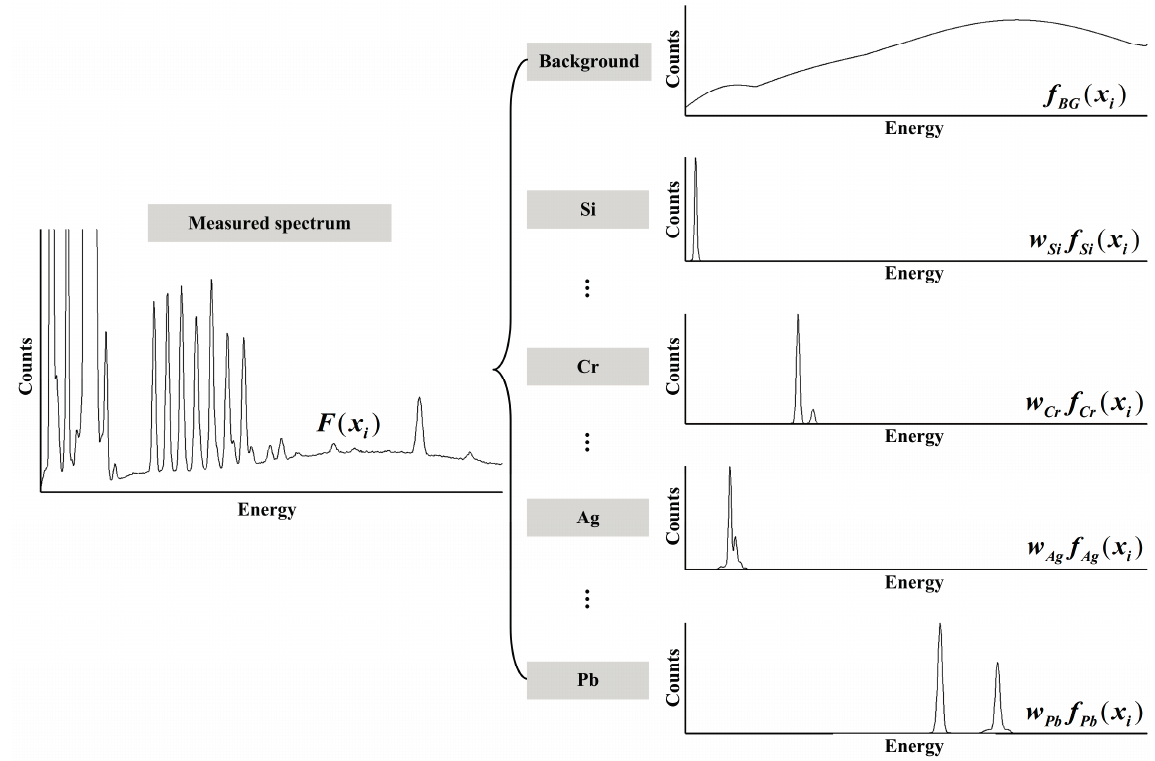
Figure 4. Spectral decomposition